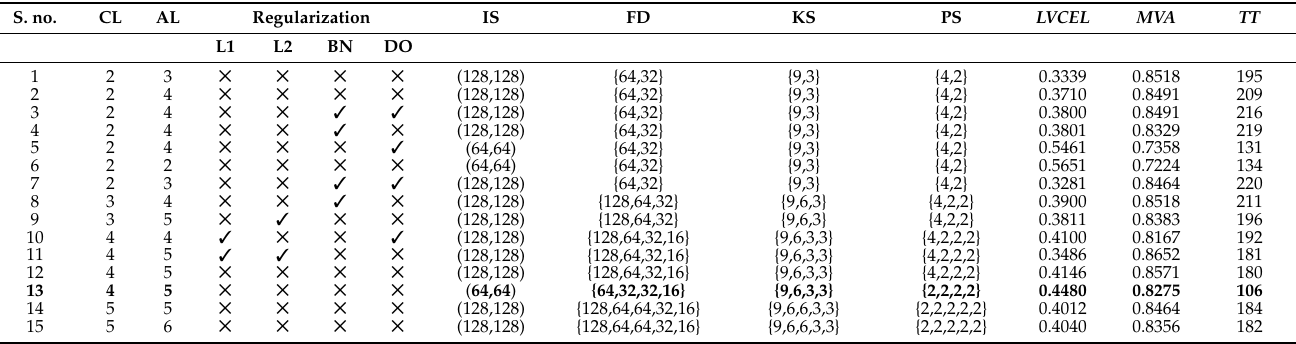
Table 2. Performance of all 15 convolutional neural network (CNN)